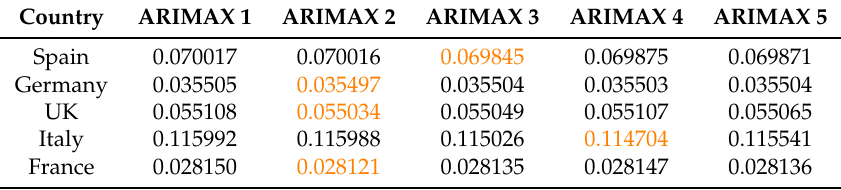
Table 11. RMSE for in-sample period of ARIMAX models for mean country spread difference.